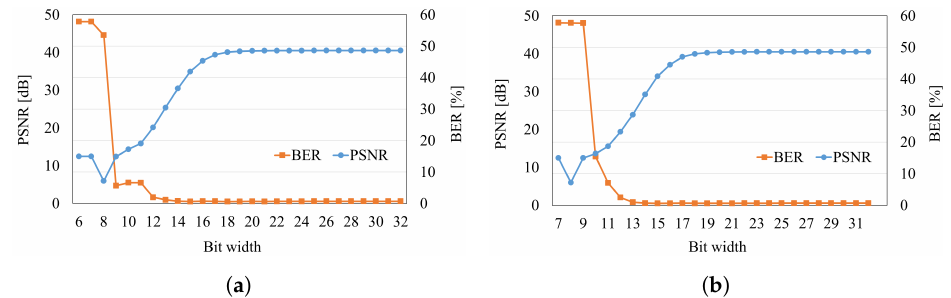
Figure 7. Precision analysis of the IFM number system ( a ) 4 bits for integer part, ( b ) 5 bits for integer